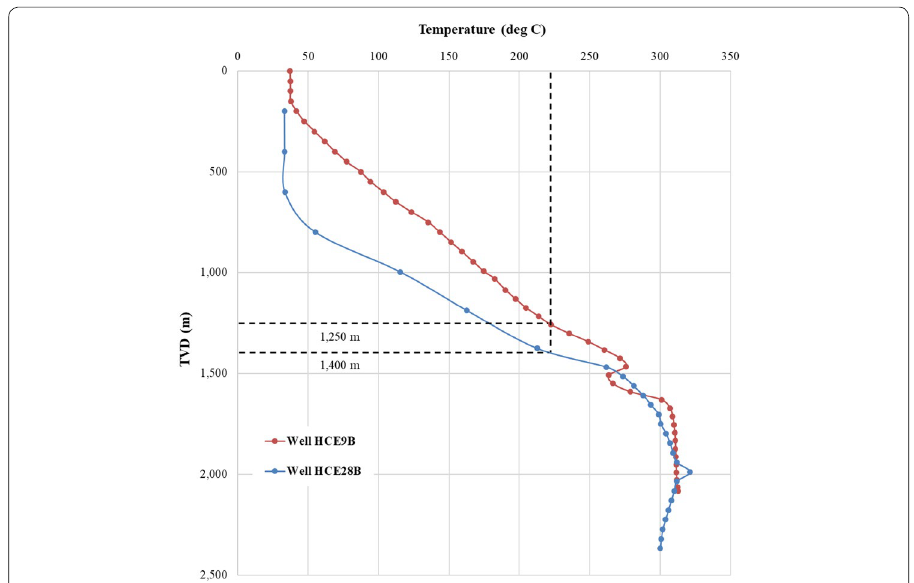
Fig. 4 The initial temperature profile of wells HCE9B and HCE28B in static condition (Marbun 2013; PT Geo Dipa Energi